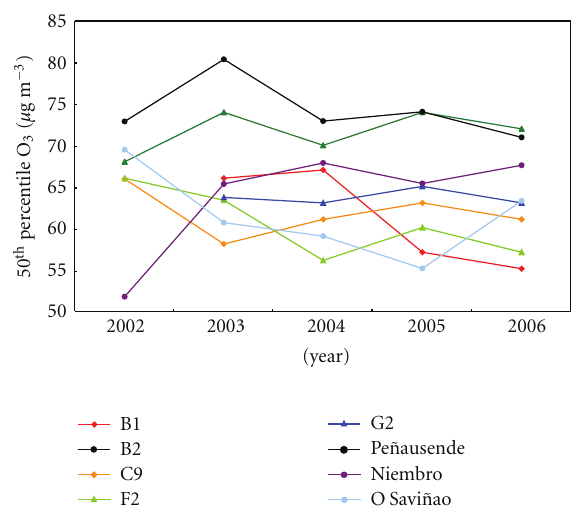
Figure 7: Internannual variability of tropospheric ozone concen- tration represented by the 50th percentile throughout the 5-year- study period (2002–2006) for each site.